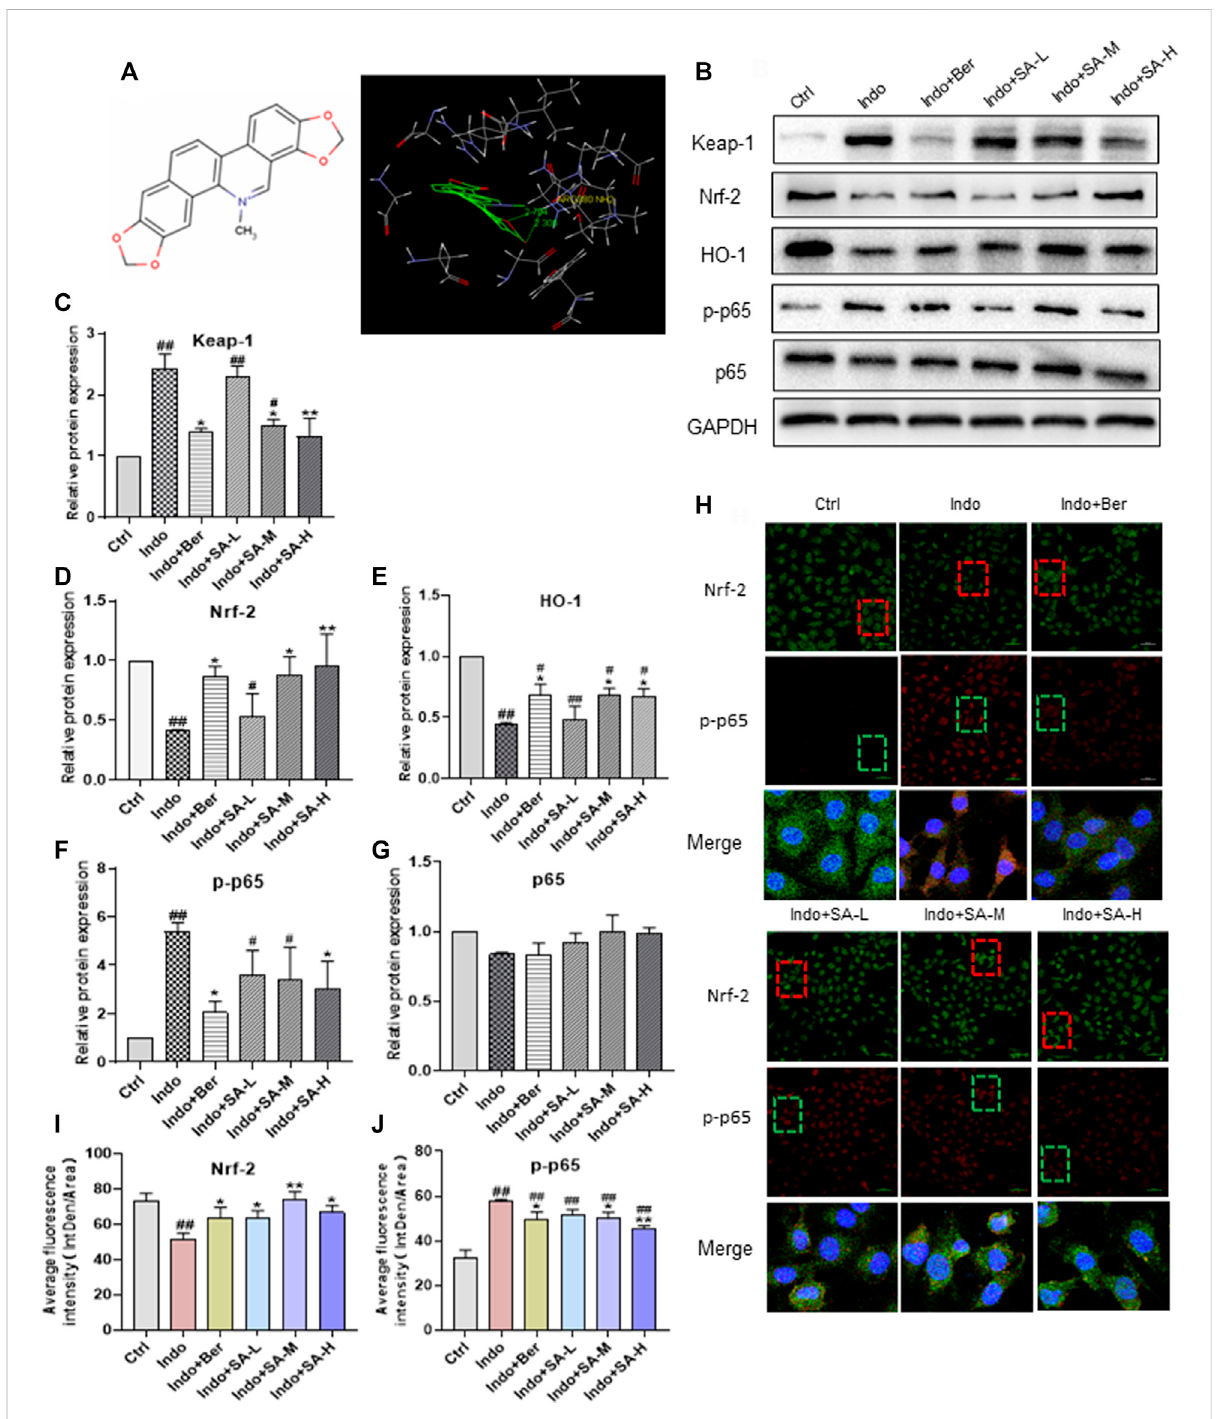
FIGURE 7 BindingofSAtoKeap-1toregulatetheexpressionofNrf2,p-p65,andHO-1inindomethacin-treatedIEC-6cells.Molecularliganddockingwas performedbetweenSAandtheKEAP1usingGold3.0.IEC-6cellsweretreatedwithindomethacin(Indo,300 μ mol L − 1 )and/orsanguinarine(SA,0.25, 0.5, and 1.0 μ mol L − 1 , SA-L, SA-M and SA-H, respectively) or with berberine (Ber, 30 mmol L − 1 ). Total cell protein and nuclear proteins of IEC-6 cells were extracted. (A) the structure of SA (left) and interaction of SA and Keap-1 (right). (B – G) Protein levels of Keap-1 increased, but decreased signi fi cantly in Ber and SA treatment groups. The expression of phosphorylated NF-kB p65 (p-p65), Nrf2 and HO-1 in IEC-6 cells, estimated by Westernblot. (H – J) ExpressionofNrf2andp-p65inIEC-6cellsshownbylaserconfocalimmuno fl uorescencestaining.Nrf2andp-p65werelabeled with red and green FITC, respectively. The nuclei were stained with DAPI (magni fi cation at ×200). Data are presented as the mean ± SD ( n = 3). # p < 0.05 and ## p < 0.01 vs. control (Ctrl). * p < 0.05 and ** p < 0.01 vs. indomethacin